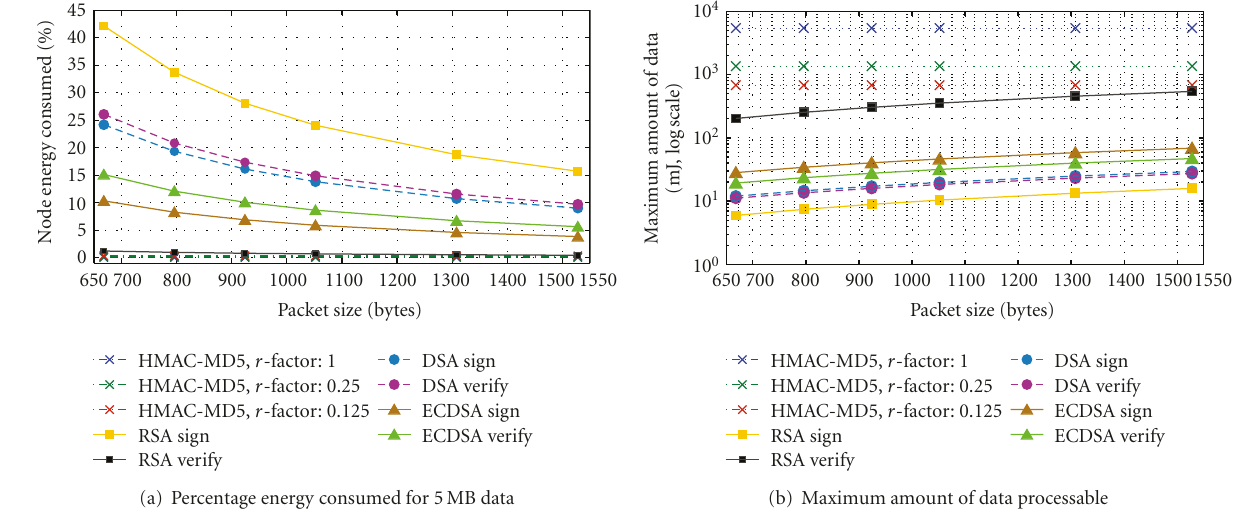
Figure 15: Energy performance comparison of di ff erent authentication protocols on iPAQ H3670.